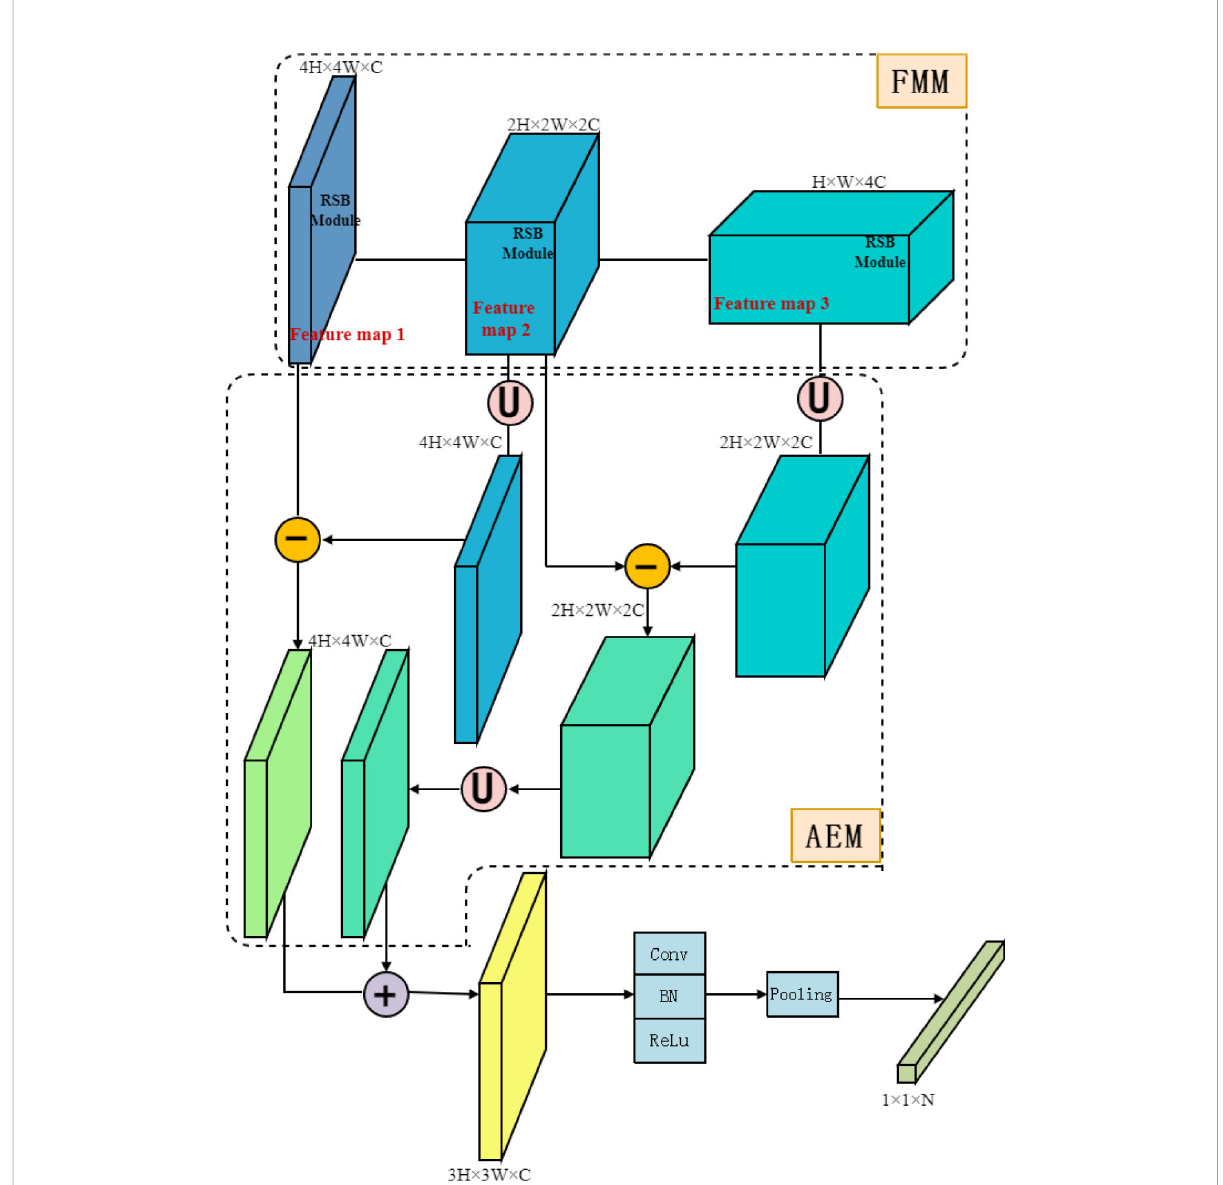
FIGURE 8 Feature Multiplexing Module and Adjacent Erasing Module. “ U ” represented an upsampling operation to expand the resolution of the feature map by a factor of two and a 1×1 convolution operation to reduce the number of channels; “ - ” represented an element-by-element subtraction operation for the feature map; “ + ” represented an element-by-element addition operation for the feature